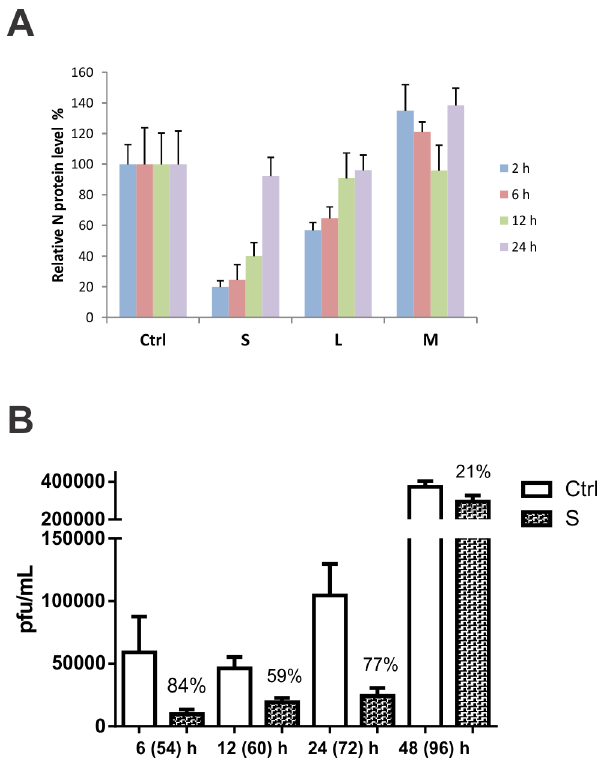
Figure 3. siRNA inhibits ANDV replication and release when administered post-infection in Vero-E6 cells. Vero-E6 cells were infected with ANDV at MOI =0.5. After virus adsorption for 2 h, the virus inoculum was removed and replaced with fresh media. Cells were then transfected with 100 nM siRNA 2, 6, 12, or 24 h post-infection. Time shown in parentheses indicates the total h post-infection. (A) N protein levels as determined by immunolabeling assays. (B) Infectious virus release as measured by immunofocus assays. After virus adsorption for 2 h, virus was removed and fresh media replaced. The cells were transfected with 100 nM siS for 6, 12, 24, or 48 h post- infection. Cell supernatants were harvested after 2 days, and infectious virus production was determined by immunofocus assays. All experi- ments were performed in triplicate. Data indicated above each bar represent percentage reduction in comparison to scrambled siRNA control.